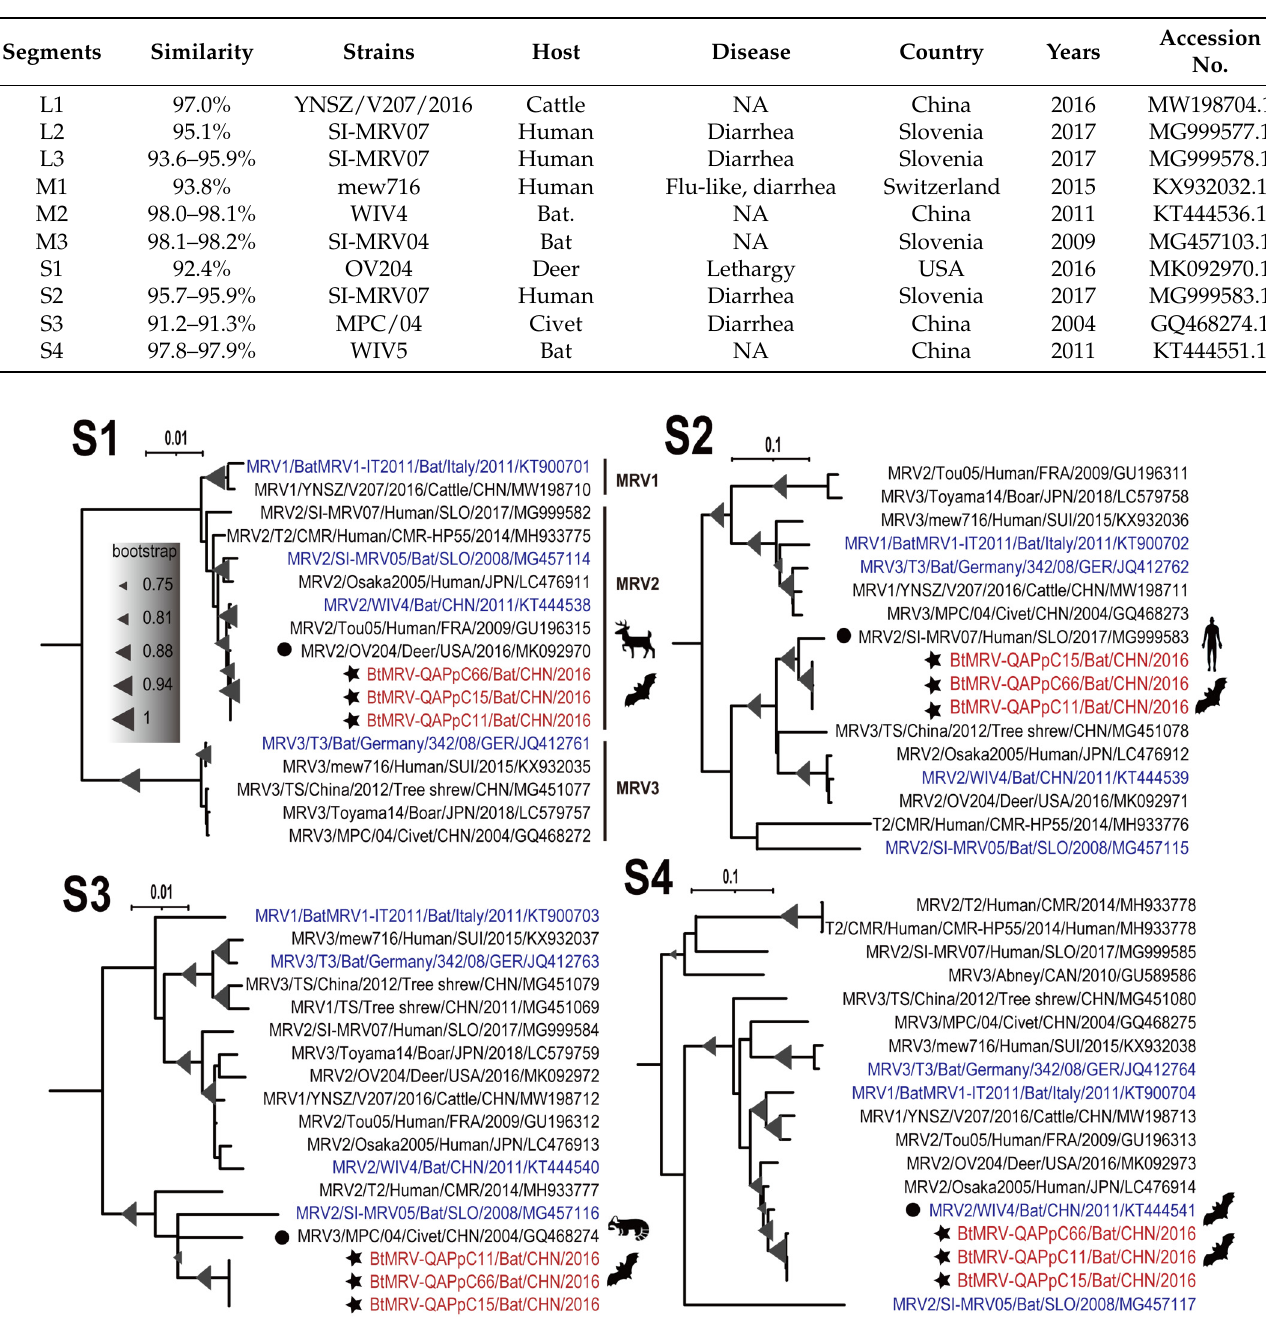
Table 2. The highest nt similarities of BtMRV QAPpC11, 15 and 66 to their reference sequences. NA: not available.